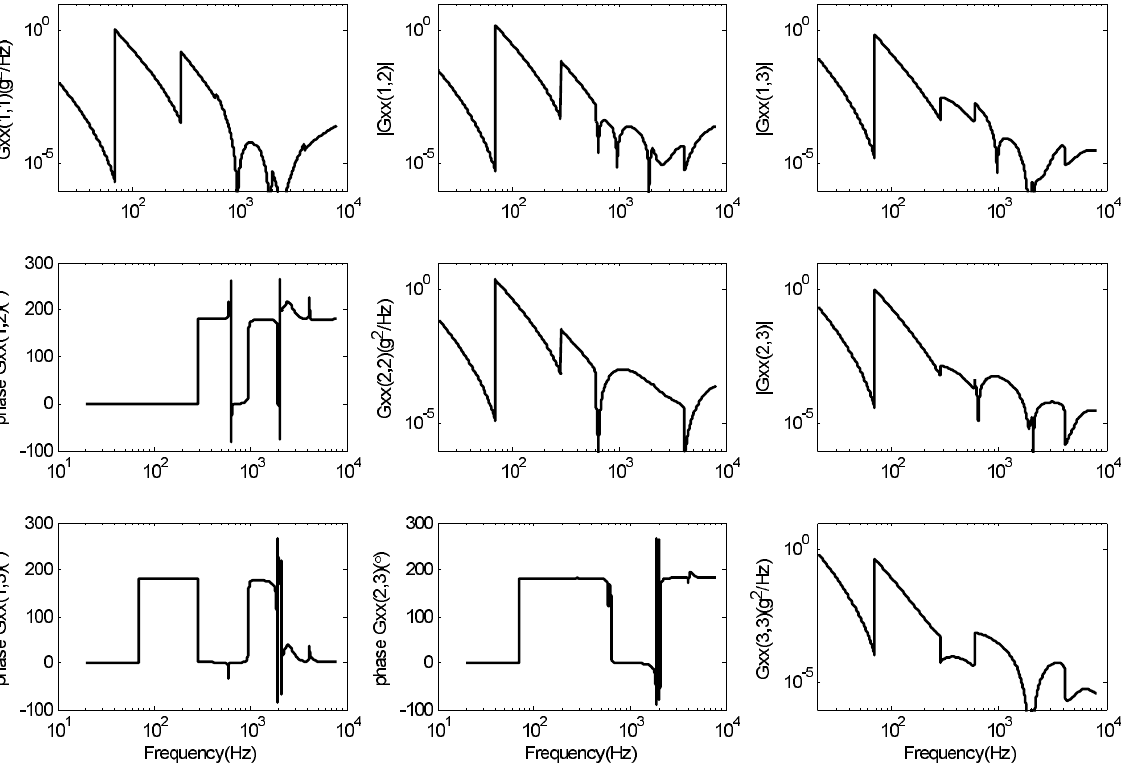
Fig. 20. Input cross spectral density matrix for the cantilever beam